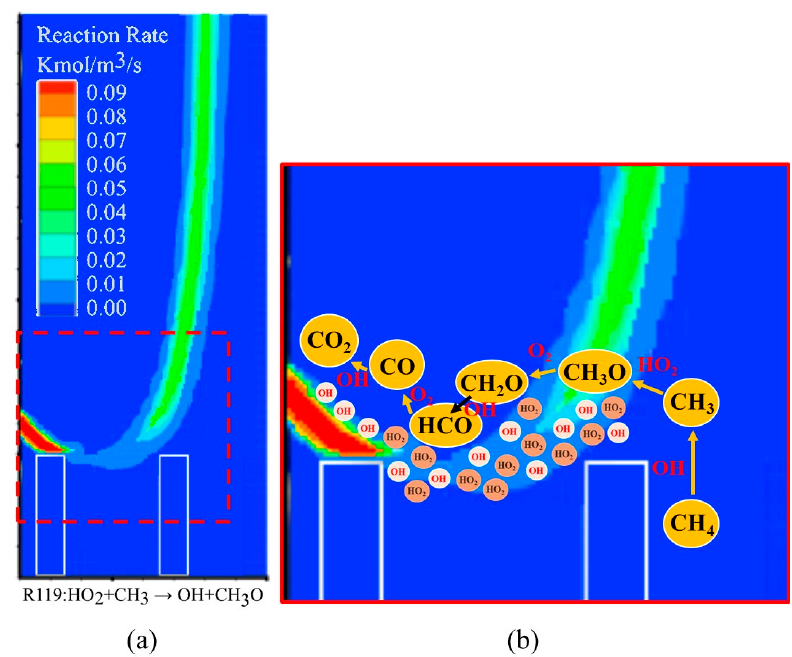
Figure 13. ( a ) The reaction rate distribution of the outstanding reaction of R119: HO 2 + CH 3 ⇔ OH + CH 3 O, and ( b ) the enlarged plot of the jet exit wall-proximity region with a schematic expression of the reaction process of the ultra-lean flame near the flame base.